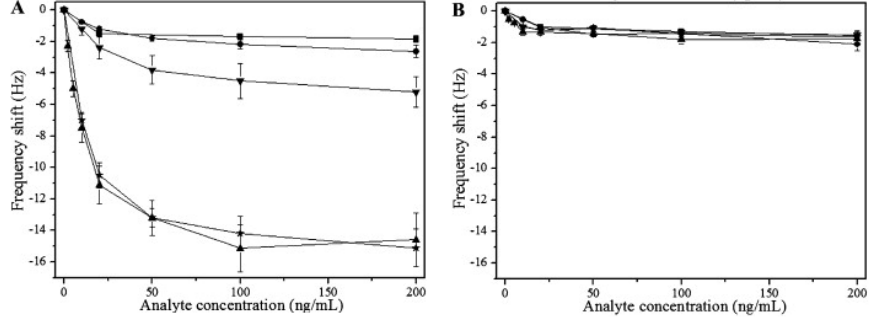
Figure 7. The sensor responses of imprinted ( A ) and non-imprinted ( B ) are shown towards HIV-1 gp 41 related peptide ( ▴ ), 2M-peptide ( ★ ), 11M-peptide ( ▴ ), GA-16-NH2 (●) and BSA ( ■ ). The error bars shows the standard deviation in triplicated experiments, reproduced with permission from [120].